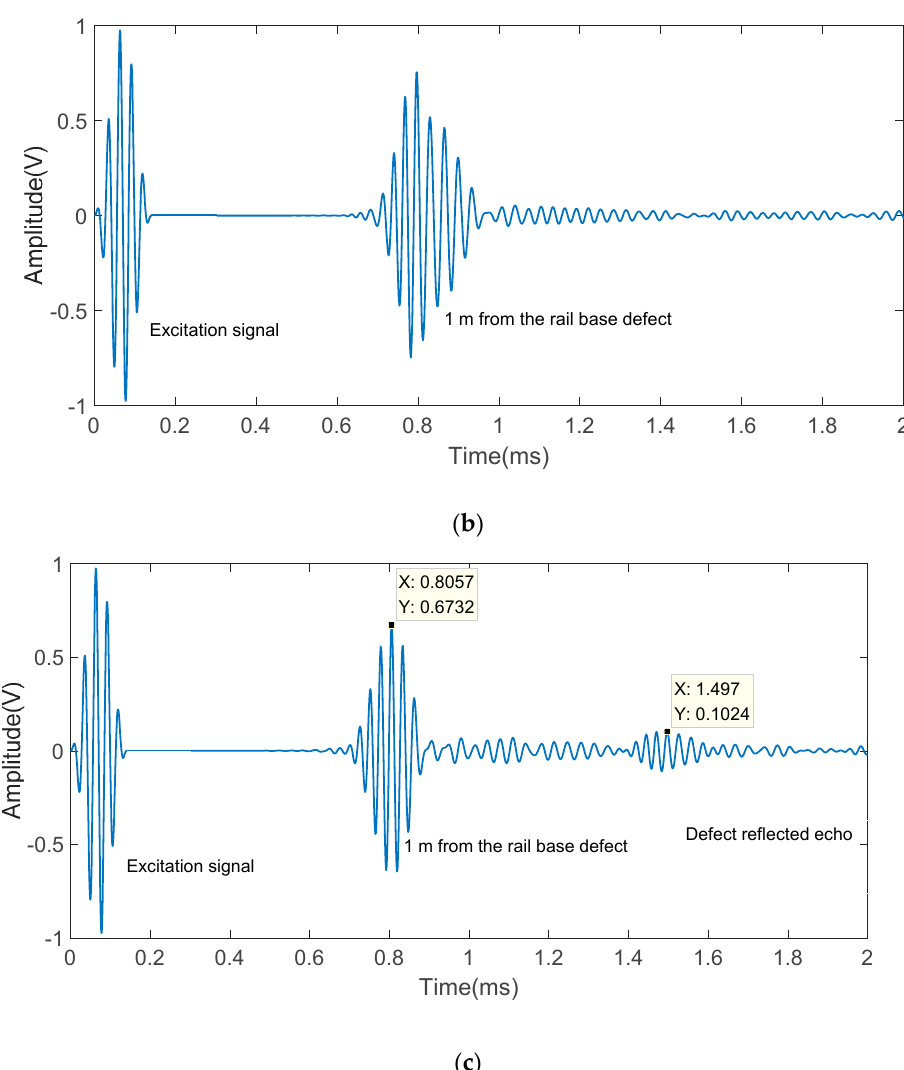
Figure 18. Rail base defect detection. ( a ) Mode 7 rail base defect detection; ( b ) mode 3 rail base defect detection; ( c ) mode 1 rail base defect detection.